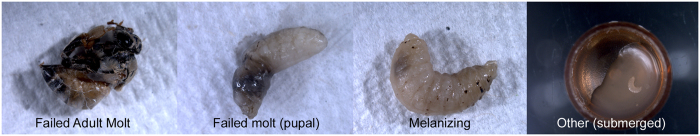
Common symptoms observed during larval rearing.Failed Adult Molt: pupae were unable to emerge from final molt successfully. Failed Molt: larvae failed to evert imaginal discs. Melanizing: Darkening internally or externally occurring in all stages. Other: No distinct symptoms could be observed, but mortality was assessed based on lack of spiracle movement, lack of growth or development for a prolonged period, or submersion in larval diet.